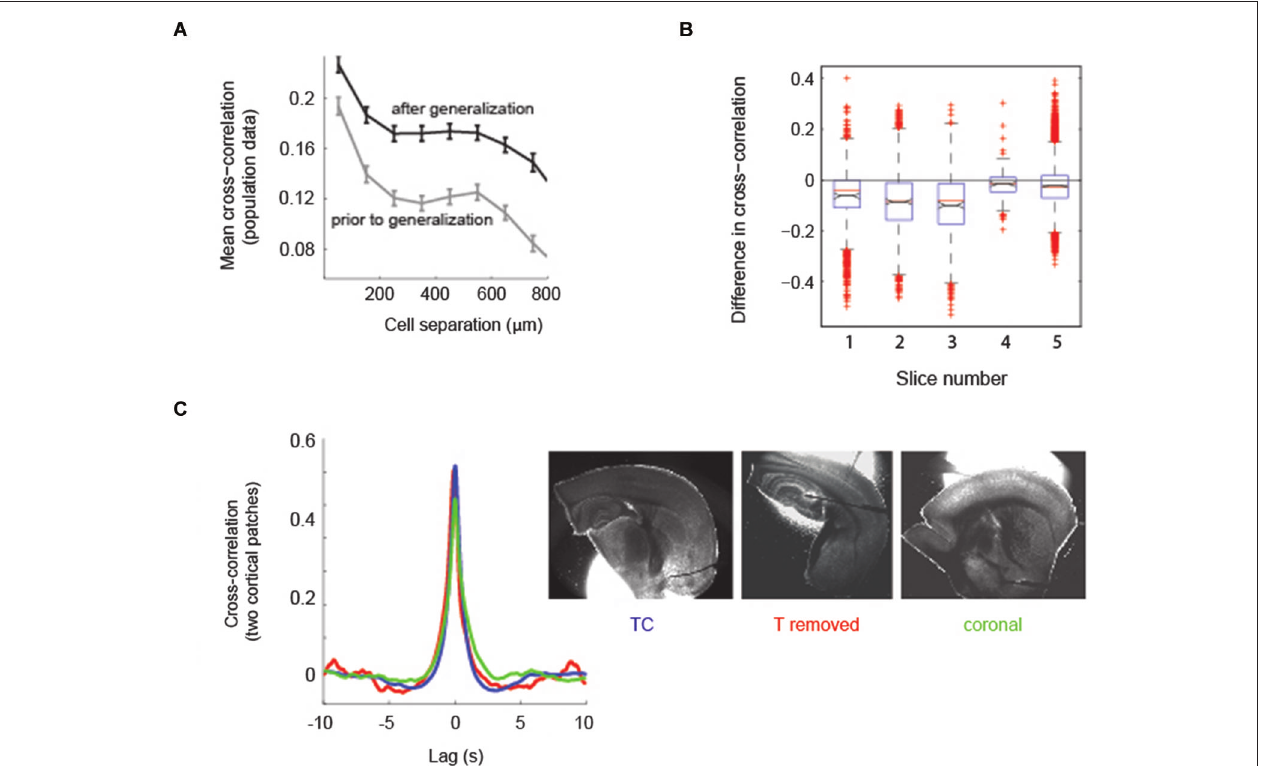
identical slices as in (A) . (C) The state change in cortex is independent of thalamus. Left: Averages of pairwise cross-correlations between electrophysiological traces of two randomly patched cells in cortex (mean distance 1278 µ m, range 723–2217 µ m) show that intra-cortical synchrony does not depend on the presence of thalamus. Blue, TC slices (TC, n = 11); red, TC slices from which thalamus was removed ( n = 4); green, coronal slices ( n = 3). Right: One example for each slice preparation, out of the slices used for analysis (patch pipets partially